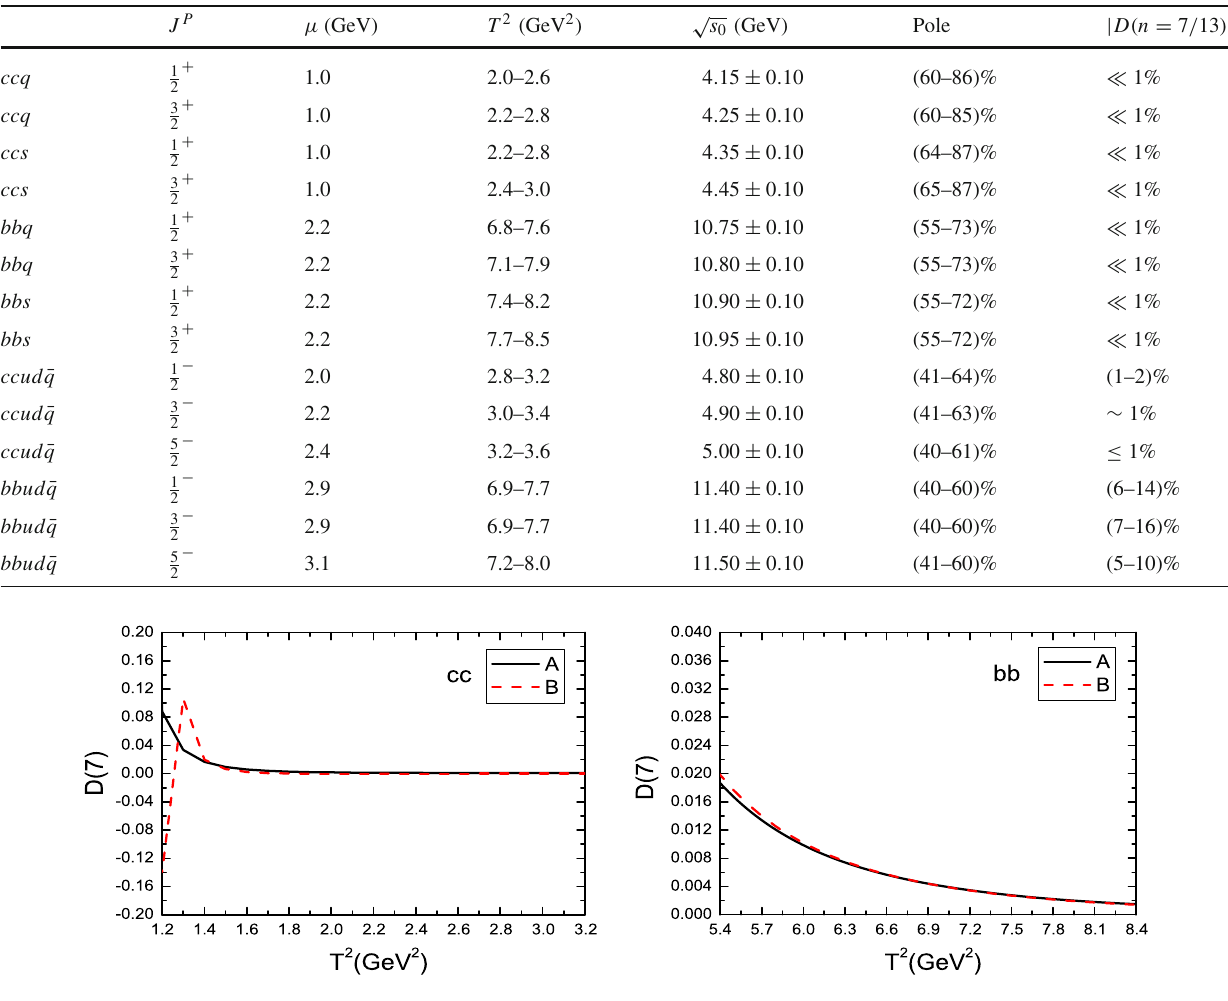
Table 2 The energy scales μ , Borel parameters T 2 , continuum threshold parameters s 0 , pole contributions (pole) and contributions of the highest vacuum condensates for the doubly heavy baryon states and pentaquark states